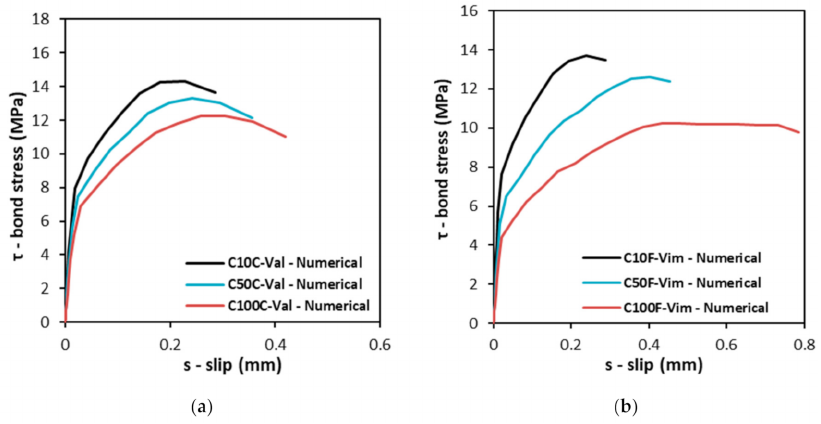
Figure 9. Numerical bond vs. slip curves of concrete mixes with ( a ) CRA from Valnor and ( b ) FRA from